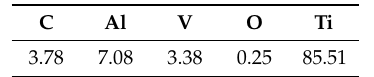
Table 1. Chemical composition (wt. %) of as-received Ti6Al4V alloy.